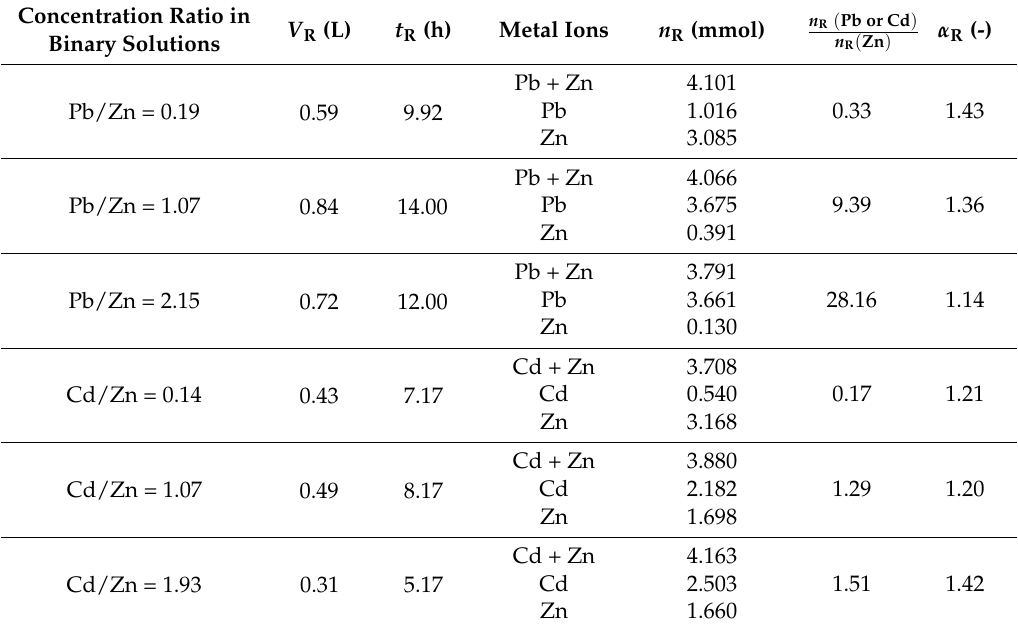
Table 2. The parameters of regeneration cycles for the (Pb + Zn) and (Cd + Zn) binary systems calculated from regeneration curves.